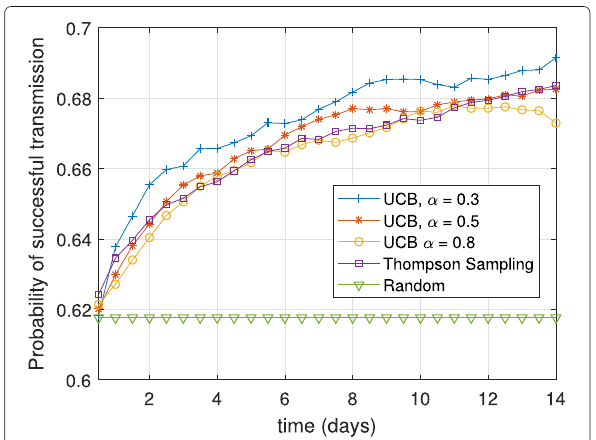
Fig. 15 Evolution of the number of successful transmissions with time for different learning schemes